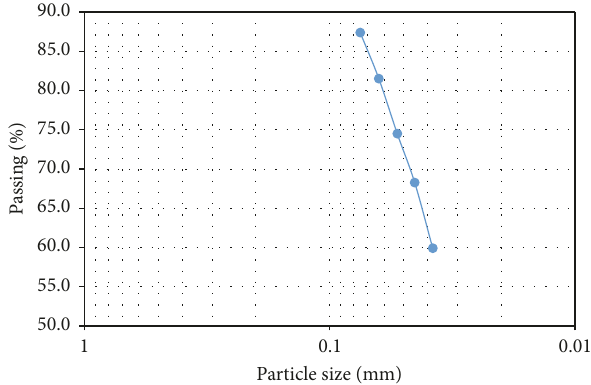
Figure 2: Particle size distribution of the flotation feed.